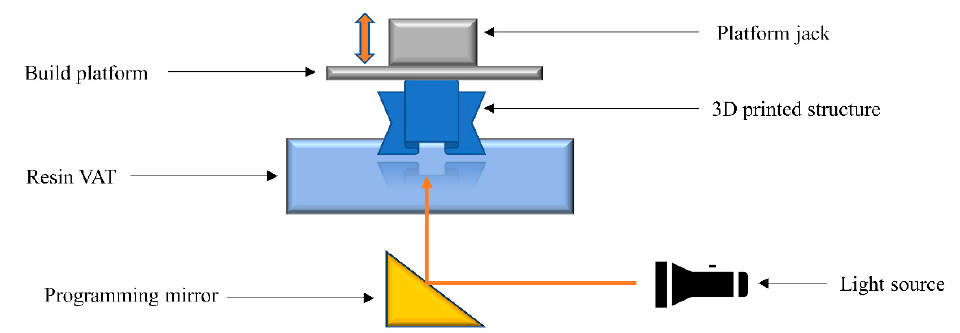
Figure 5. Schematic diagram of the stereolithography (SLA)